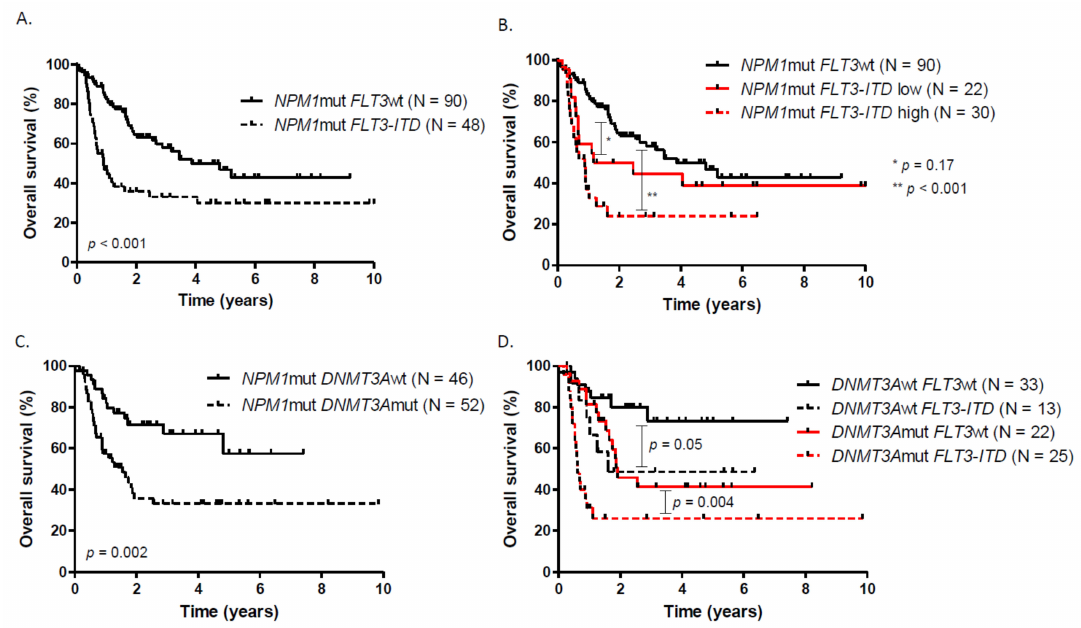
Figure 1. Overall survival according to ( A ) FLT3-ITD status, ( B ) FLT3-ITD allelic ratio, ( C ) DNMT3A status, ( D ) DNMT3A and FLT3-ITD